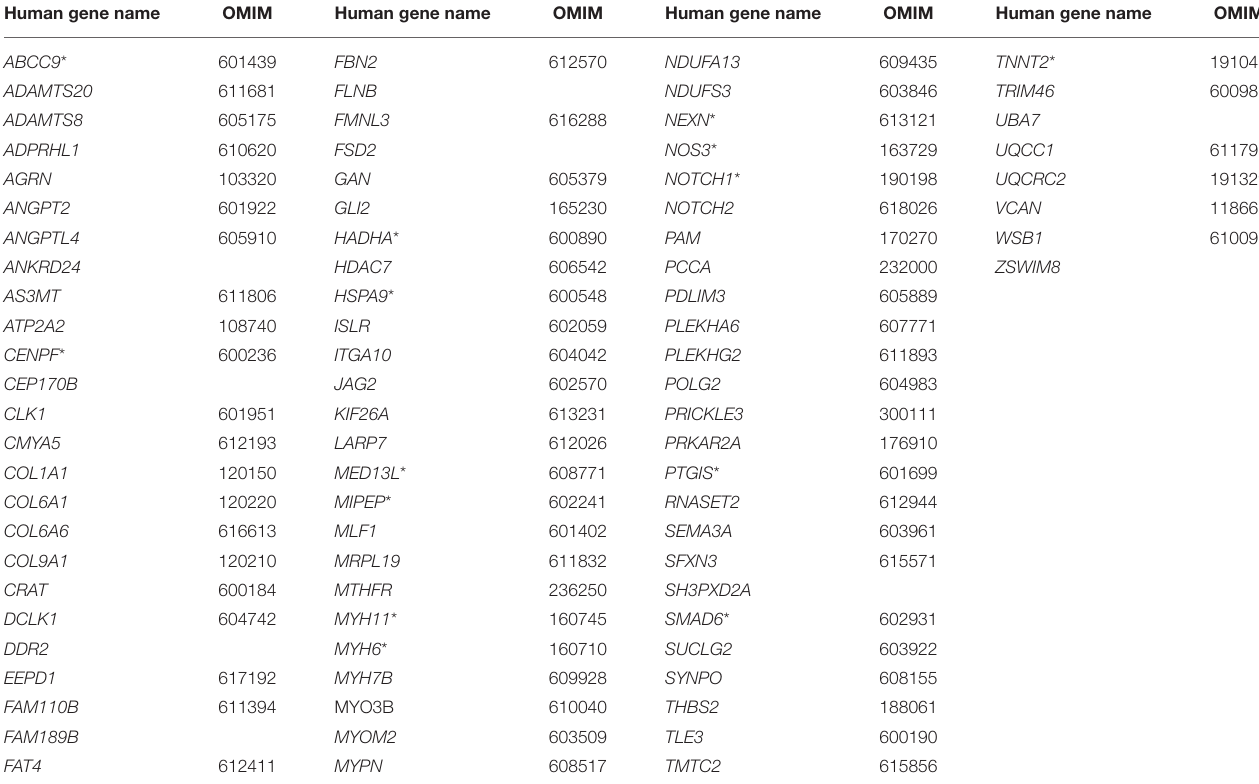
TABLE 3 | Overlapping genes between TOF-VAR-PAGE-MH and TOF-VAR-JIN-MH lists. Human gene name